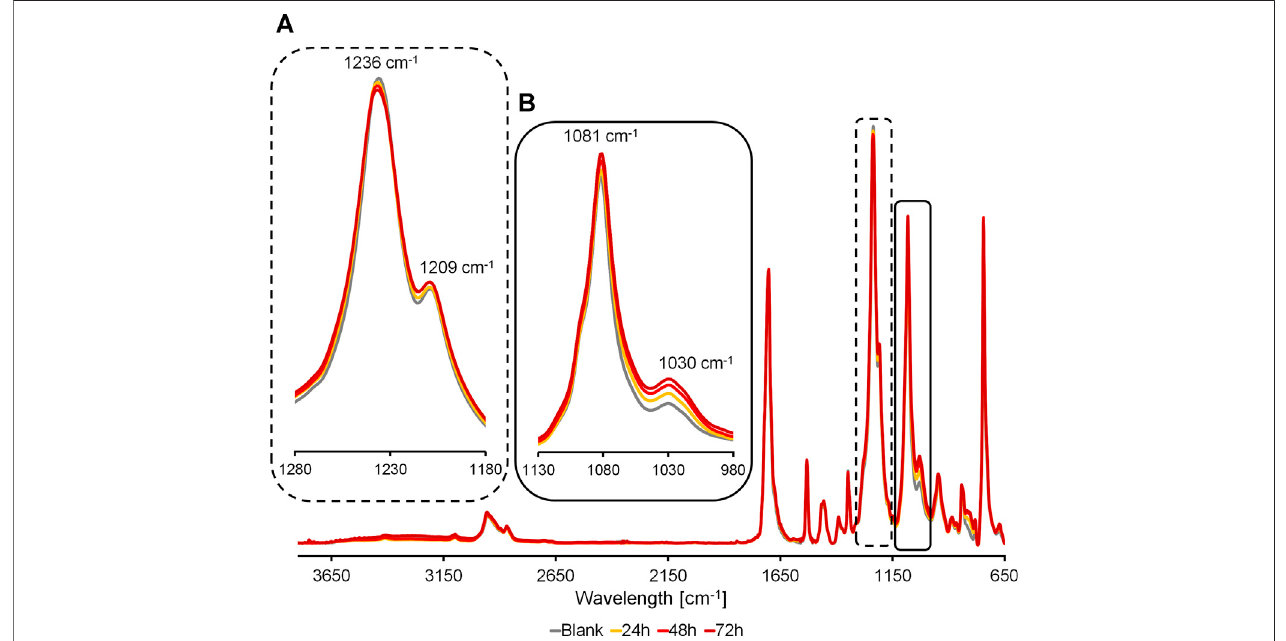
FIGURE6| FT-IRspectraofpartiallyhydrolyzed PPeTF fi lms.SamplesweretreatedwithThc_cut1 at65 ° Cfor48 h. Spectrahavebeennormalizedwithrespectto the intensity of the peak at 1703 cm − 1 . A: magni fi cation of peaks correlated to the stretching of the C-O bond of a primary alcohol and B: magni fi cation of peaks correlated to the stretching of the ester